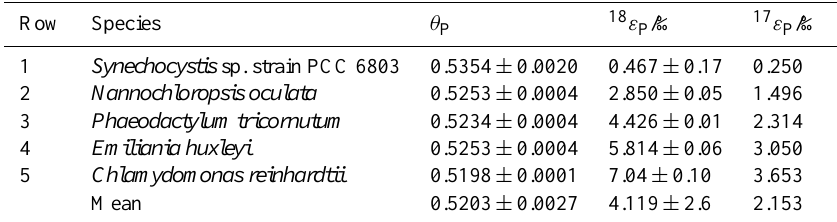
Table 2. Photosynthetic oxygen isotope fractionation for different marine (rows 2 to 4) and freshwater (rows 1 and 5) species (Eisenstadt et al., 2010; Helman et al., 2005). The third decimal of 18 ε P in rows 2 to 4 has been reconstructed from Luz and Barkan (2011b). The mean θ P value has been calculated from a linear regression of the five species-dependent ln(1 + 17 ε P ) and ln(1 + 18 ε P ) values. It is useful for error propagation purposes. The resultant y-axis intercept of (0.012 ± 0.013) ‰ is statistically indistinguishable from zero. For clarity, θ P and 17 ε P values are shown with the same number of decimals, irrespective of their